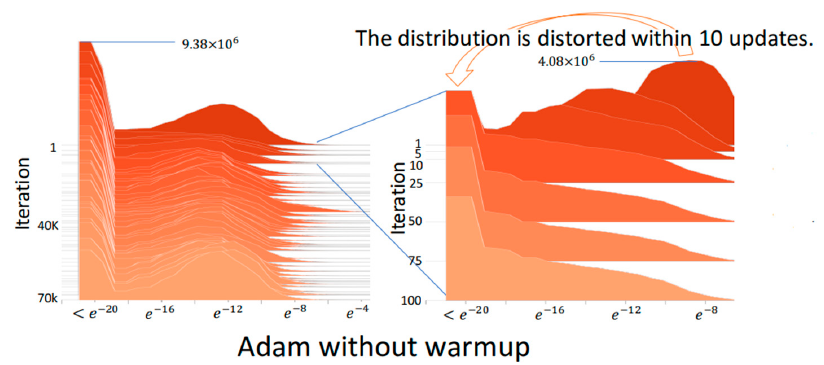
Figure 2. The residual block structure.